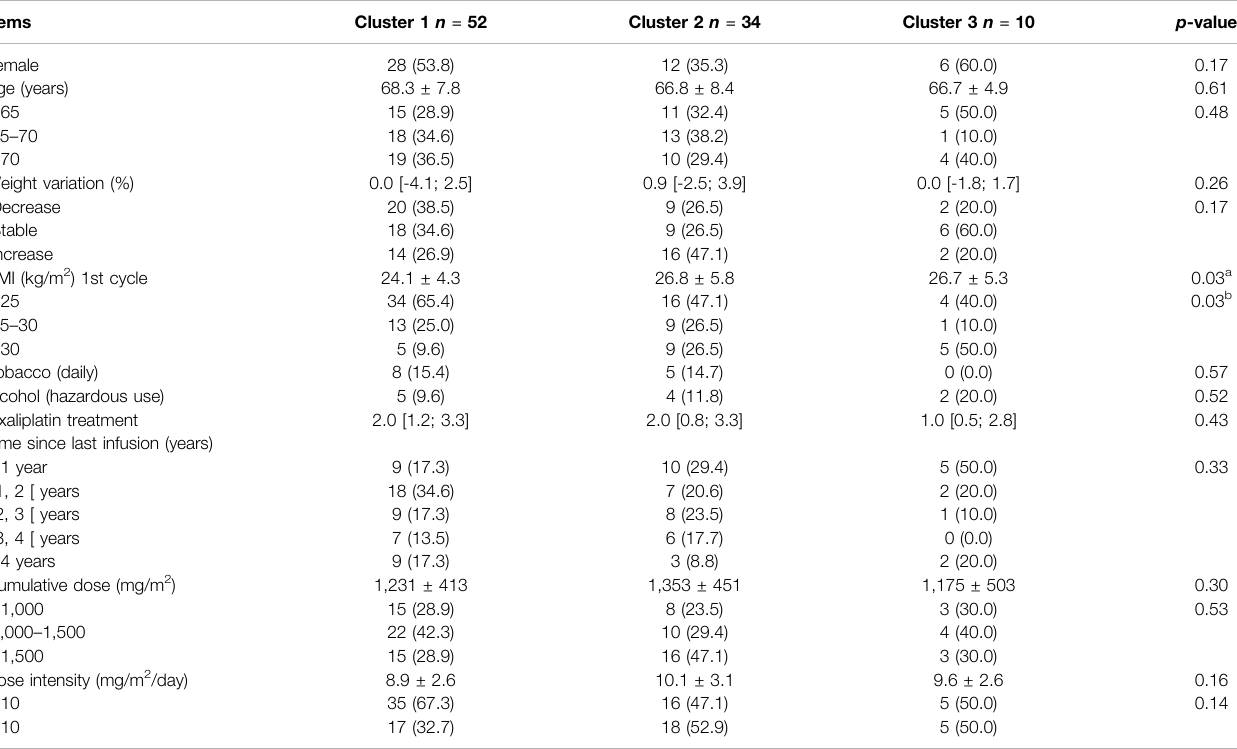
TABLE 2| Characteristics ofthepatientsaccordingto theircluster.Dataarepresentedas number (percentages), mean ± standard deviation or median [interquartile range]. Hazardous alcohol use (males: ≥ 21 alcohol units/week and females: ≥ 14 alcohol units/week). Weight variations were de fi ned as follows: decrease (-2% between fi rst oxaliplatin infusion and last one), increase (+2%) and stable (less than -2 and 2%). BMI: body mass index. Signi fi cant difference ( p < 0.05, post hoc analysis) between: a, cluster 1 and cluster 2; b, cluster 1 and cluster 3; c: cluster 2 and cluster 3.